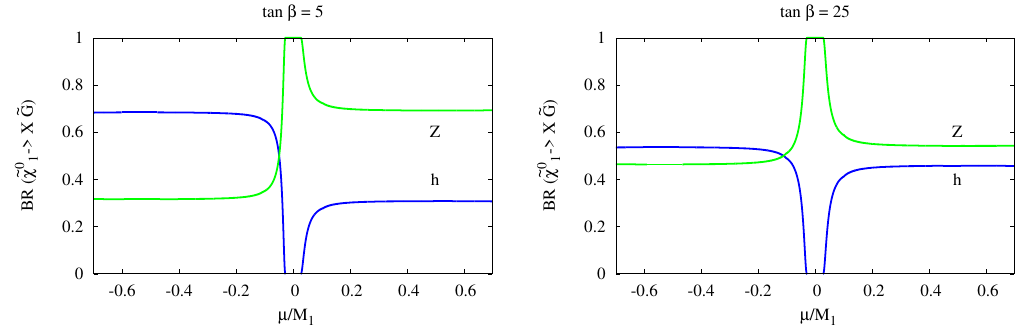
Figure 1 . Variation of the branching ratios of the boson (green lines) as a function of ratio (cid:22) in table 1. Two plots are for tan (cid:12) = 5 and 25